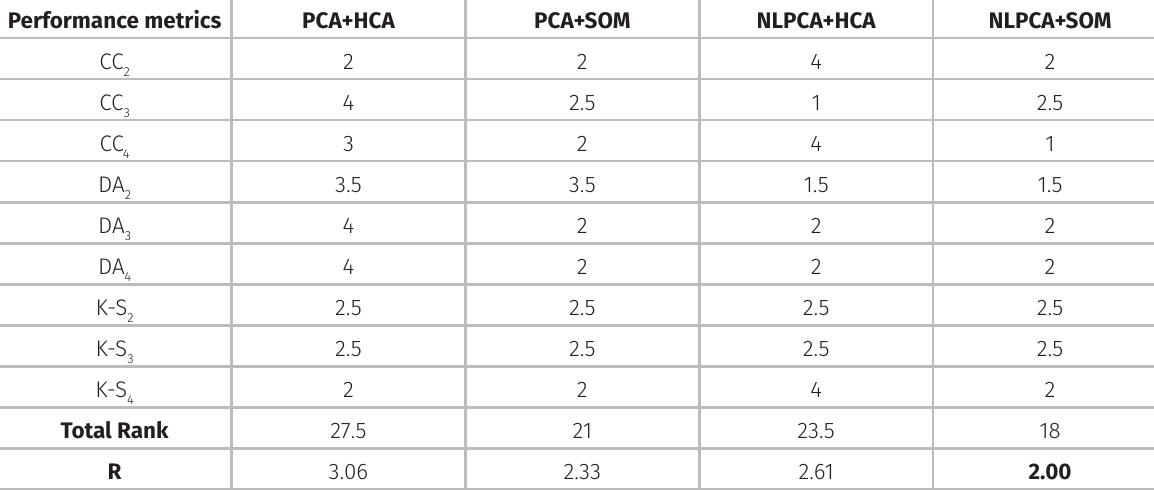
Table V Ranks of clustering methods found for performance metric. Performance metrics